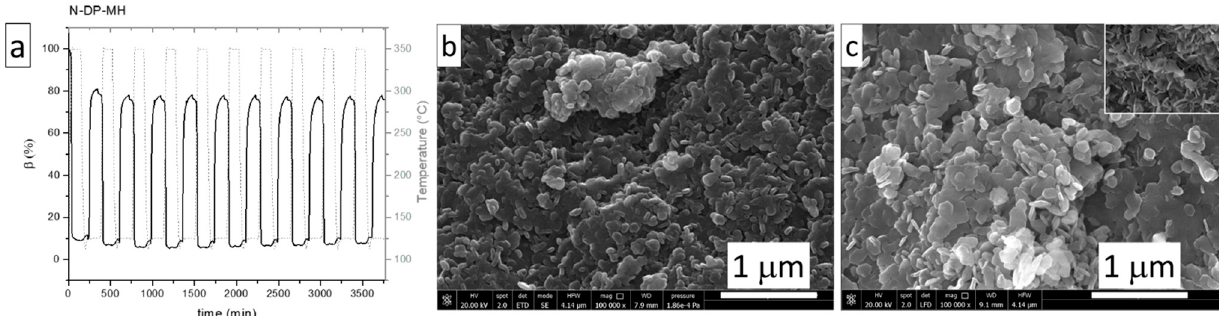
Figure 9. N-DP-MH thermochemical stability over ten cycles experiment ( a ); SEM images of as-prepared N-DP-MH ( b ) and of N-DP-MH after 10-cycle experiment ( c ).